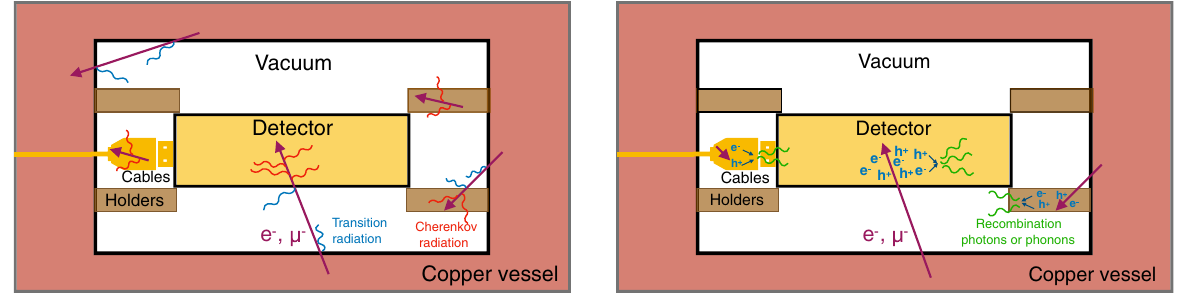
FIG. 1. Schematic for the production of radiative backgrounds: Cherenkov and transition radiation (left) and recombination photons and phonons (right). High-energy electrons (from ambient radioactivity or radioactive contaminants) and cosmic-ray muons (purple) can (i) interact in nonconductive materials, including the detector target and the surrounding materials, such as holders and cables, to produce Cherenkov radiation (red); (ii) cross surfaces to produce transition radiation (blue); and (iii) deposit energy to create luminescence or phonons via, e.g., the recombination of electron-hole pairs (green). The low-energy photons or phonons obtained by these processes can then be absorbed in the detector target, producing a measurable signal that depends on the target properties but that can take the form of, e.g., one or more electrons, photons, or phonons, which can mimic the low-energy signals produced by low-mass dark matter interacting with the detector